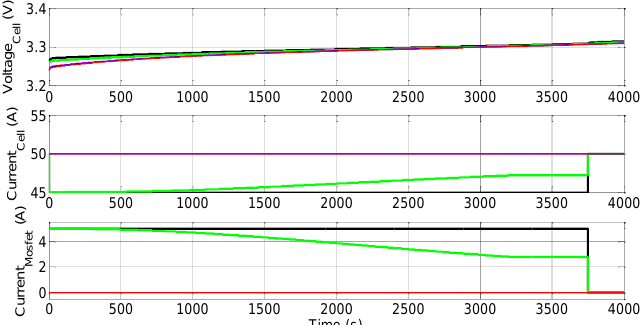
Fig. 6. From top to bottom, cell voltages (V), currents (A), and MOSFET currents (A) during a charging